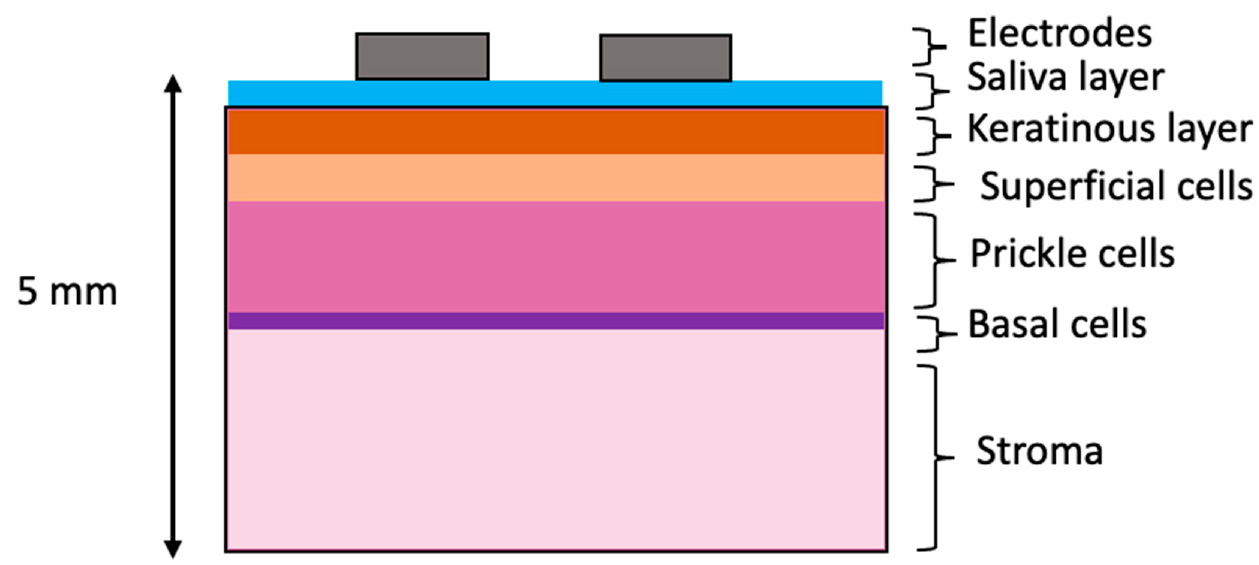
Figure 5. Schematic of tissue-level layered model. Note that layer thicknesses are not to scale. The same principles for simulating EIS at the cellular scale were applied at the tissue scale, with the addition of the definition of boundary conditions to represent the tetrapolar electrode array, as shown in Figure 6. Specifically, the electrodes were modelled as circles attached to the outer surface of the top layer in the tissue scale model (see Figure 6a). The nodes of each of the electrode areas were defined as unique coupled sets. The electrode spacing and radii were taken from the specifications of the ZedScan device (see Figure 6b). The drive electrode had an applied current of 6.08 µ A (AC peak current, as per the ZedScan device) and the receive electrode was grounded, by setting the potential to 0 V.